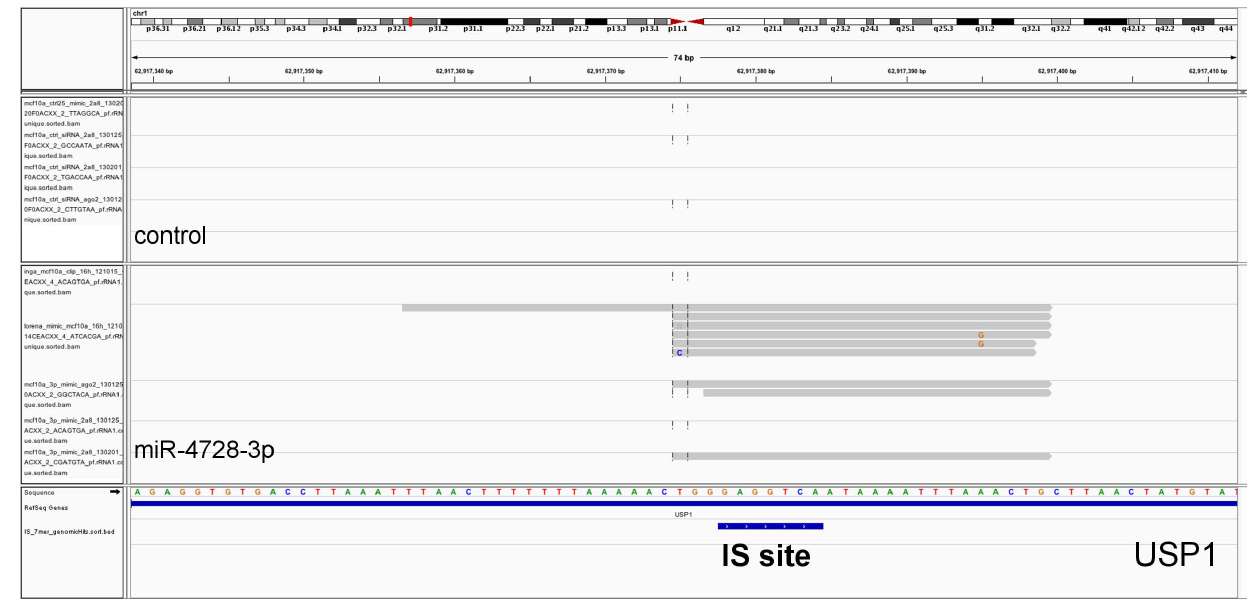
Figure 2. IGV view (Integrative Genomics Viewer) showing the enrichment of AGO-CLIP sequencing reads in miR-4728-3p transfected vs non-transfected control around the IS target site on the 3 9 UTR of the Ubiquitin carboxyl-terminal hydrolase 1 (USP1) gene. The positions of the 7- and 6-mer IS target sites are highlighted below the USP1 gene.